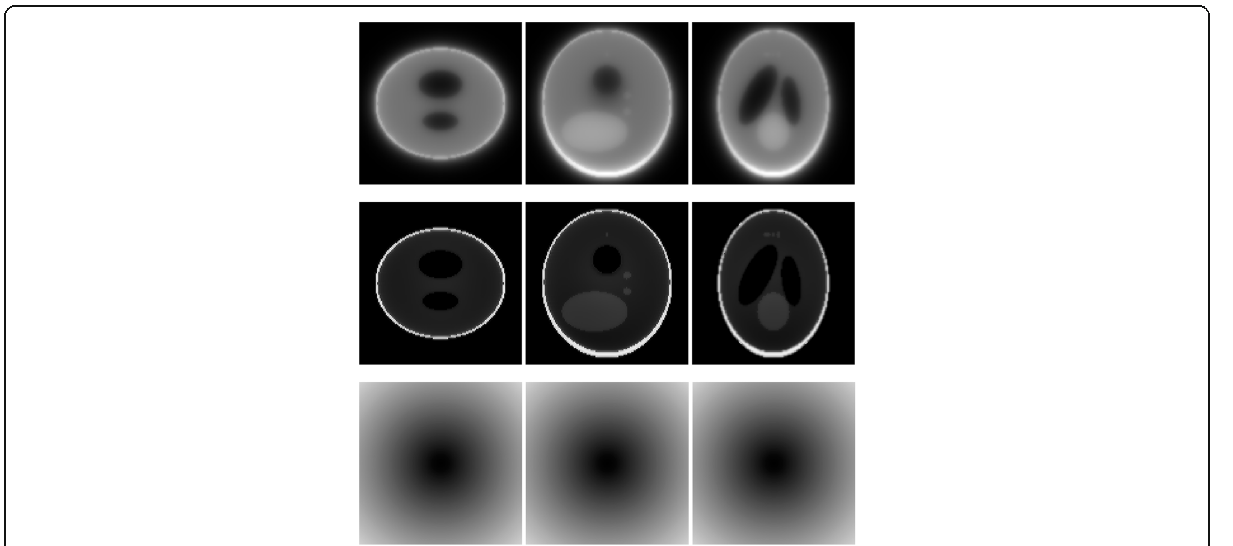
Fig. 13 Image reconstruction using proposed algorithm for the case of ψ = π /2 and σ = 10. This is the ‘ 4 π ’ case. Row 1 : TOF backprojection. Row 2 : Final reconstruction. Row 3 : Tomographic filter H . Three central orthogonal cuts are shown for each